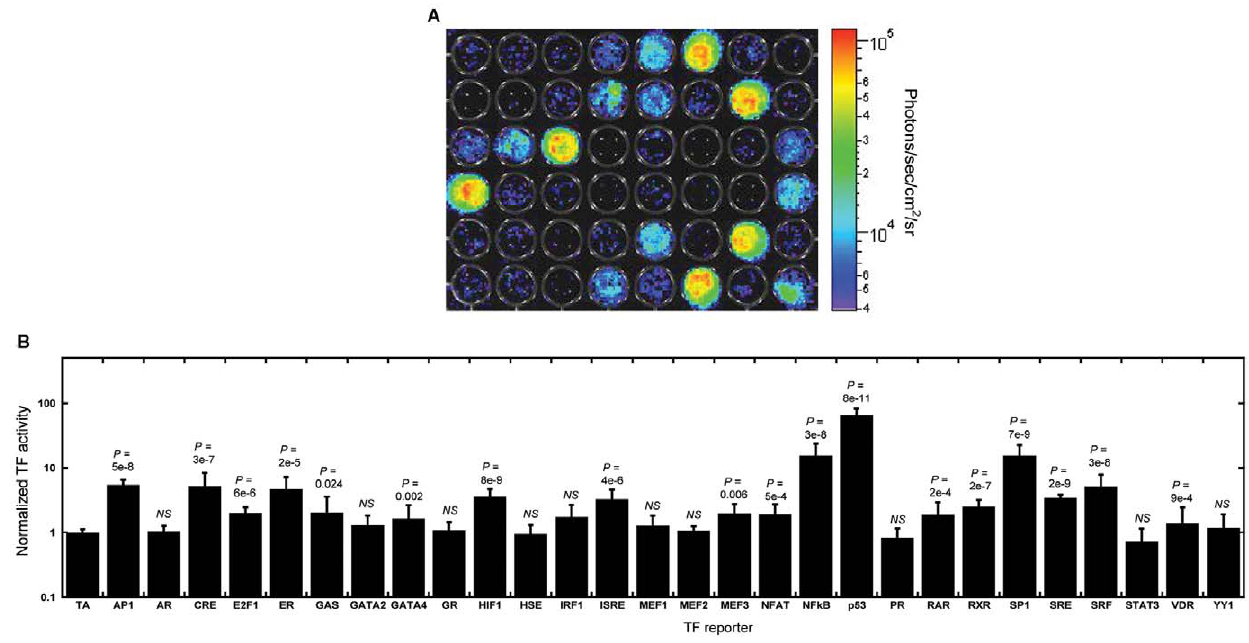
Figure 4. Large-scale arrays to monitor TF signaling in parallel. (A) Pseudo-color mapping indicated localized luminescence from wells throughout a portion of a 96-well plate randomly seeded with 16 conditions. (B) Quantification of TF activity at 24 h by bioluminescence imaging for 28 TFs. Values are means 6 s.d. from at least three independent experiments carried out in triplicate. NS indicates not significantly greater than the TA control.